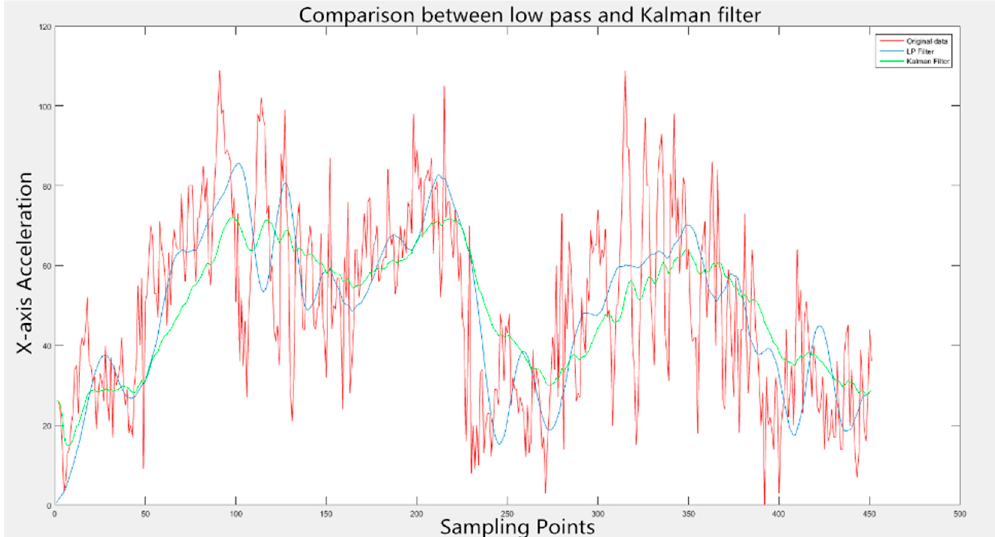
Figure 9. The performance of low pass and Kalman filters. Sensors 2016 , 16 , 1746